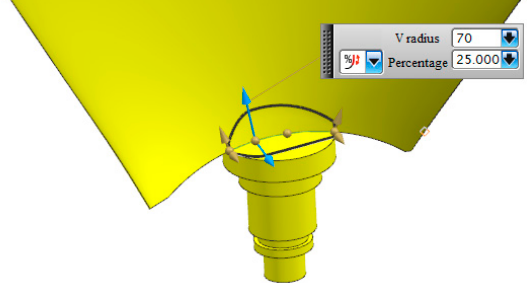
Figure 11. Design method of blades with di ff erent root